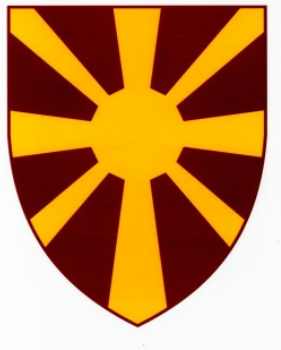
Figure 4. One of Miroslav Grchev’s proposal for the coat of arms (1995).